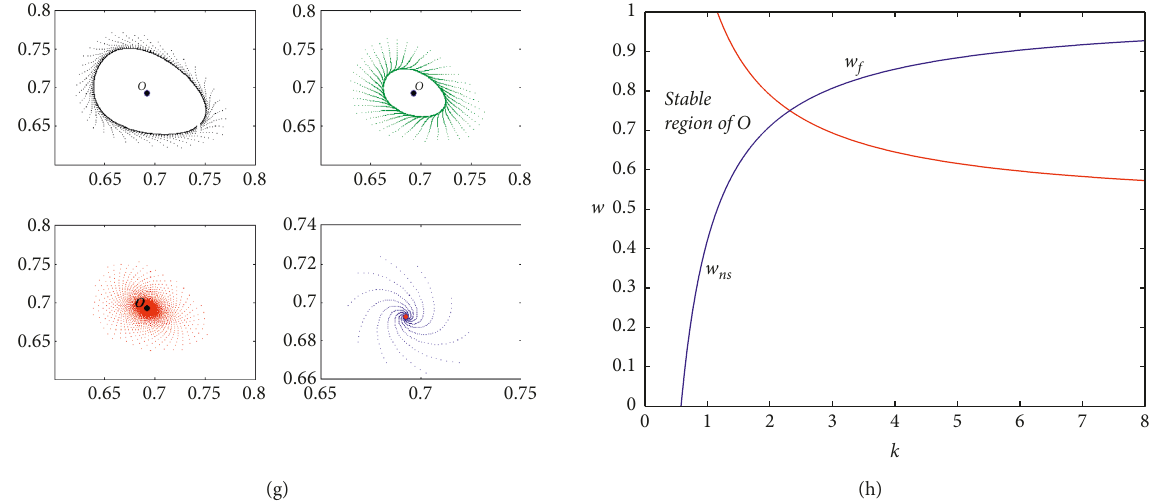
Figure 4: (a) Bifurcation diagram on varying the parameter of memory ω at k � 1 . 4. (b) Enlargement of the bifurcation diagram in a for different intervals of ω . (c) The basin of attraction of the period-6 cycle and the chaotic attractor at ω � 0 . 257536 and k � 1 . 4. (d) The basin of attraction of the period-9 cycle appearing with a closed chaotic attractor at ω � 0 . 2649 and k � 1 . 4. (e) The basin of attraction of the period-8 cycle appearing with a closed chaotic attractor at ω � . 2986 and k � 1 . 4. (f) The basin of attraction of the period-4 cycle appearing with a closed invariant curve at ω � 0 . 5883 and k � 1 . 4. (g) The phase plane of different dynamic behaviors at ω � 0 . 6 . 12 , 0 . 613 , 0 . 614 , 0 . 618 and k � 1 . 4. (h) The stability region of the equilibrium price O and the routes to chaos through flip and Neimark-Sacker using the values a � 1 and c � 0 . 46.